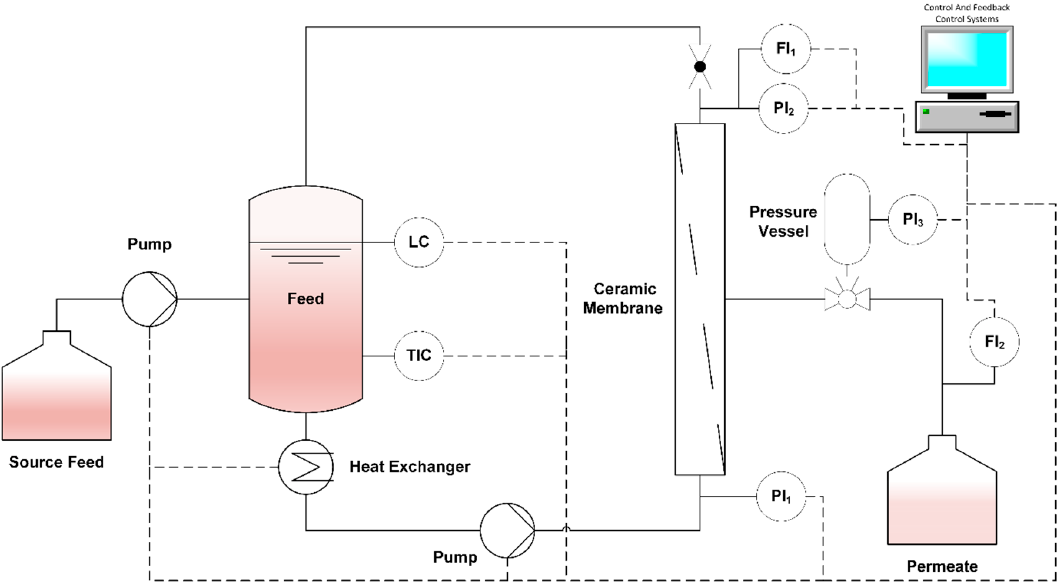
Figure 1. Schematic illustration of the laboratory-scale cross-flow ceramic membrane filtration system. Abbreviations: L = level, T = temperature, P = pressure, F = flow, I = indicator, C = controller.